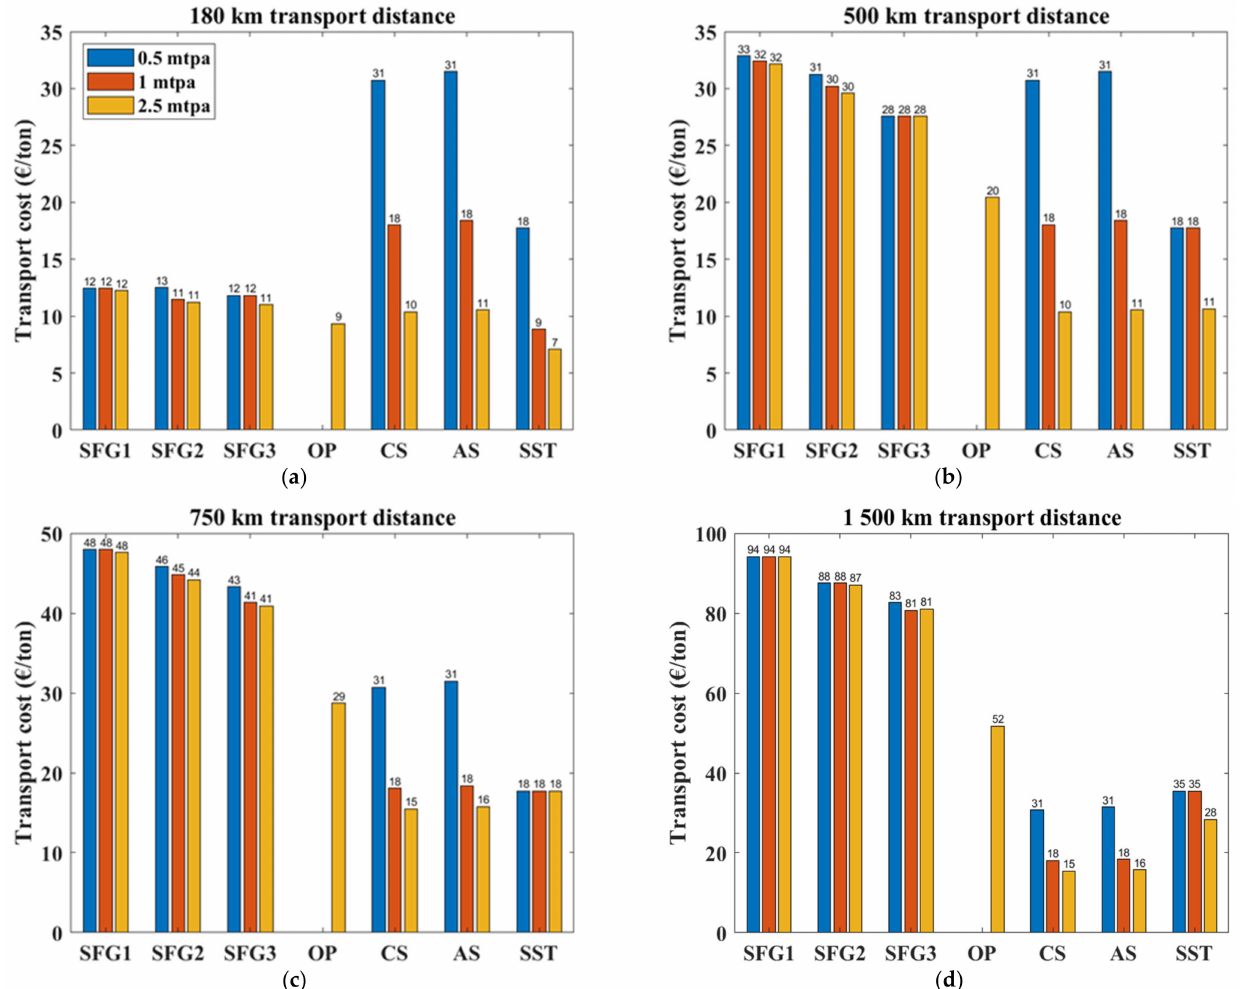
Figure 10. Results for the average cost per ton of CO 2 : ( a ) 180 km; ( b ) 500 km; ( c ) 750 km; ( d ) 1500 km. Abbreviations: SFG1: subsea freight glider (469 m 3 ); SFG2: subsea freight glider (1194 m 3 );